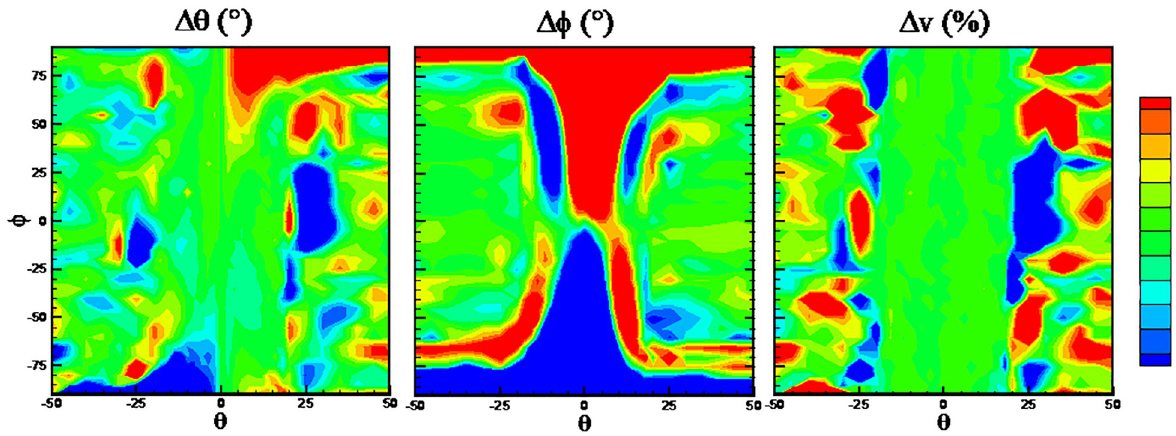
Fig 18. Error distributions with SVM algorithm.